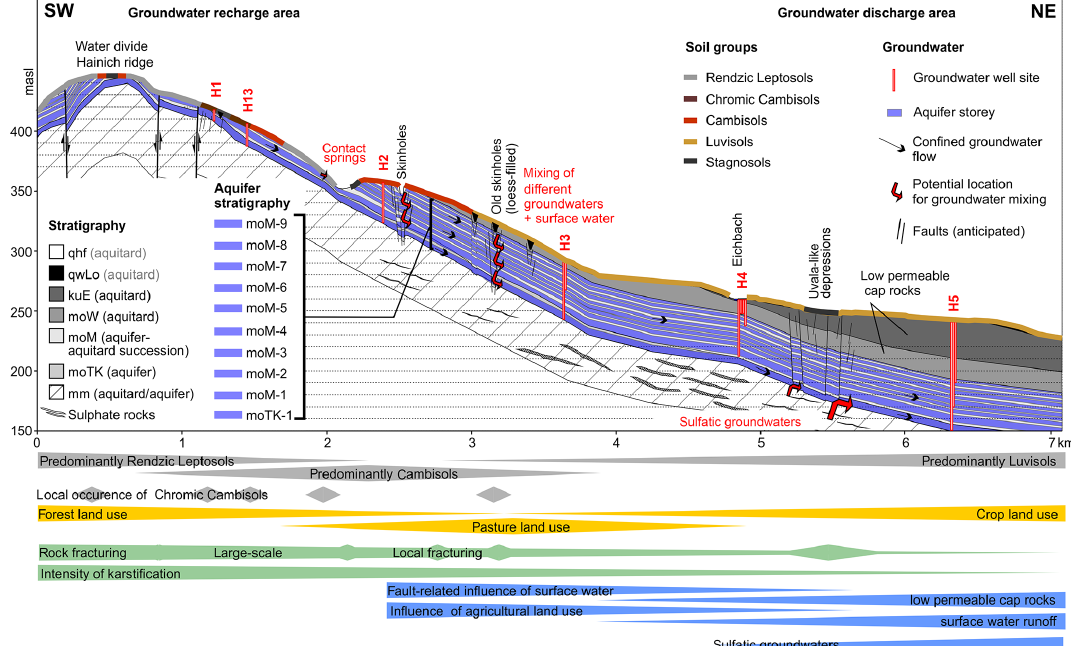
Figure 10. Conceptual cross section of the Hainich hillslope showing the overall geological structure with the 10 aquifer storeys illustrating preferential aquifer recharge zones in the summit to midslope region as well as the discharge direction. Lineaments of caprock sinkholes crossing the potential groundwater flowpath represent potential zones for descending or ascending cross-formational flow and also the mixing of different types of